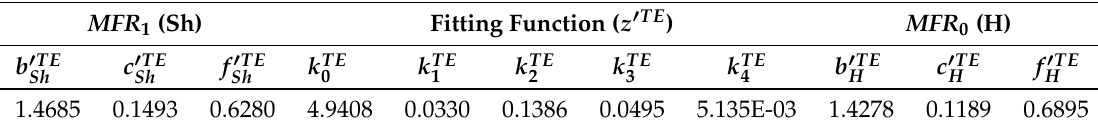
Figure 22. Analysis of T#1TE turbine outlet temperature error with different parameters in order to find an a correction function to reduce the error. ( a ) Error with MFR x and same reduced turbine speeds, ( b ) Error with reduced turbine speed of each branch and MFR x , ( c ) Error with the BSR of each branch and MFR x , ( d ) Error with same reduced turbine speed for different MFR x and BSR. Table 5. Fitting coefficients of mixed turbine outlet temperature correction with new fitting function for